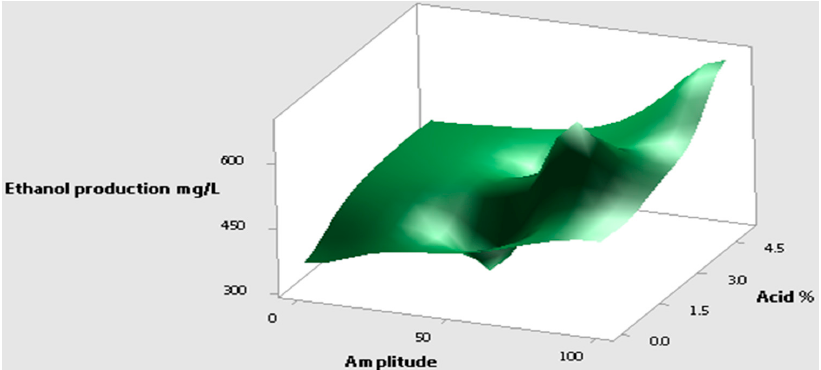
Figure 4. Surface plot for ethanol (mg/L) produced vs. amplitude and acid %.